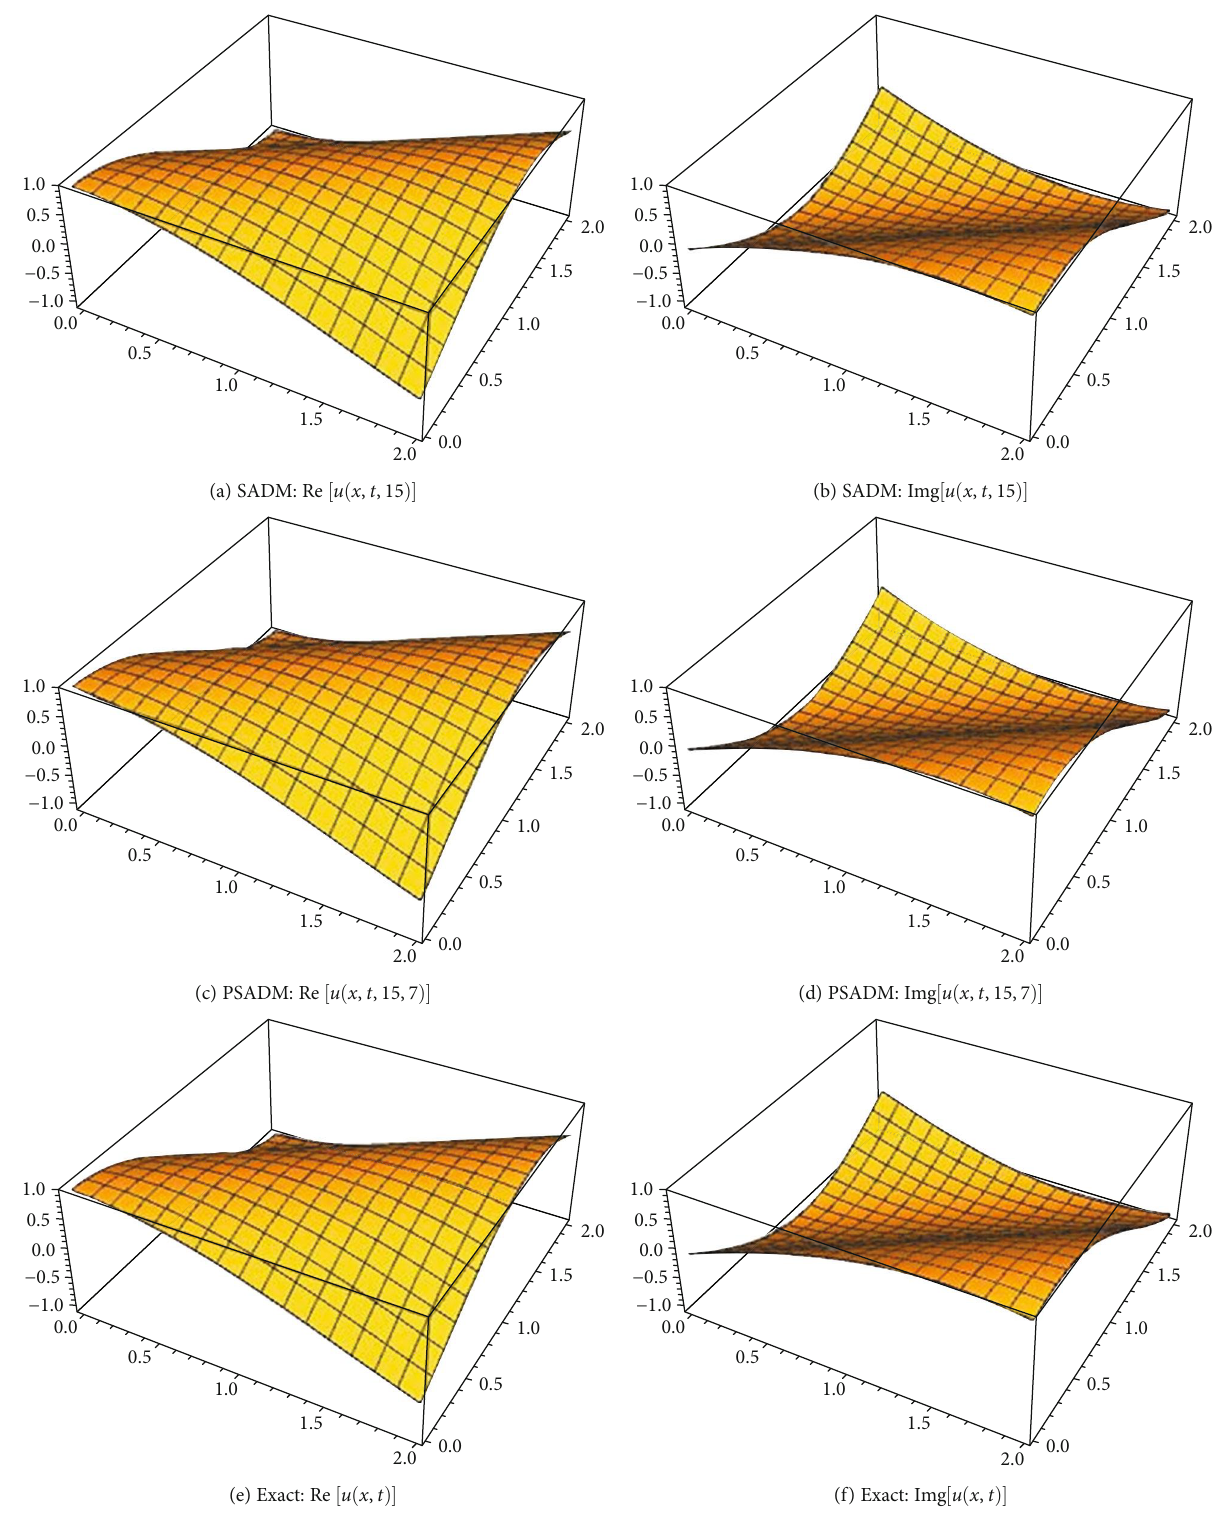
Figure 7: (a – d) SADM and PSADM solutions using 15 terms. (e, f) Exact